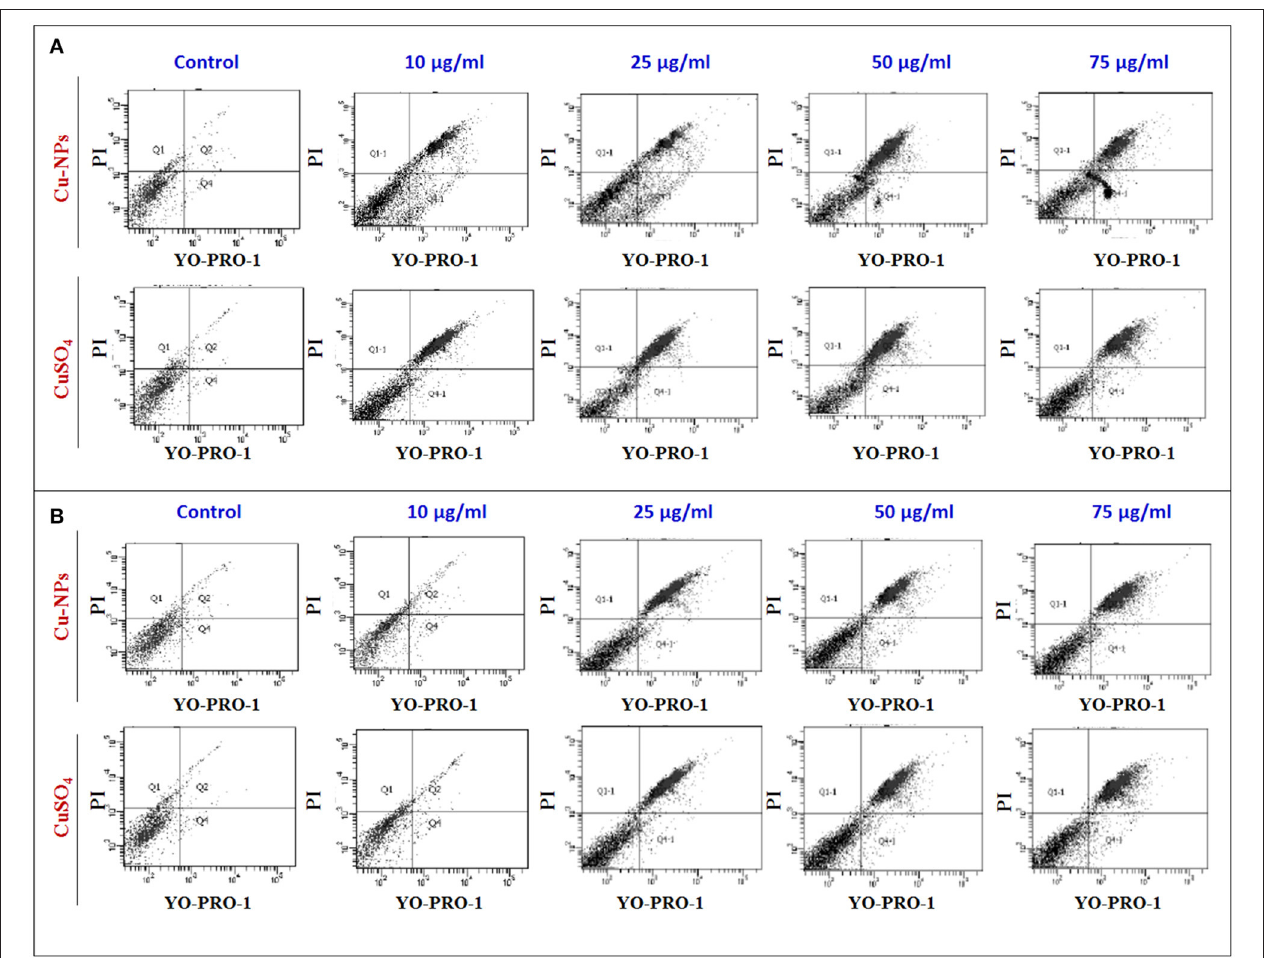
FIGURE 7 | Flow cytometry analysis of catfish primary testicular culture (6A) and TM3 Leydig cell culture (6B) exposed to increasing concentration of Cu-NPs and CuSO 4 and evaluated using YO-PRO-1 and PI labeled dye. All figures stained with YO-PRO-1 which represented early apoptotic cells (lower right quadrant) and cells stained with both YO-PRO-1 and PI (upper right quadrant) which denoted late apoptotic cells were calculated and compared with the control. The percentage of cells were calculated and listed in Supplementary Table